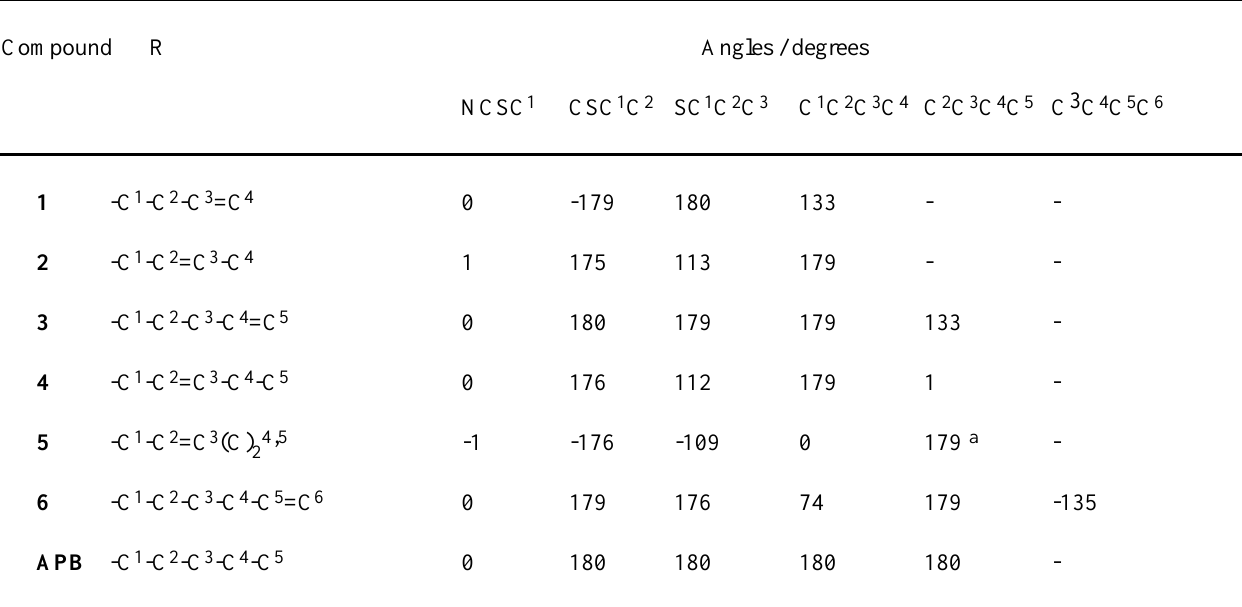
Table 4. Rotation angles of the alkyl groups of